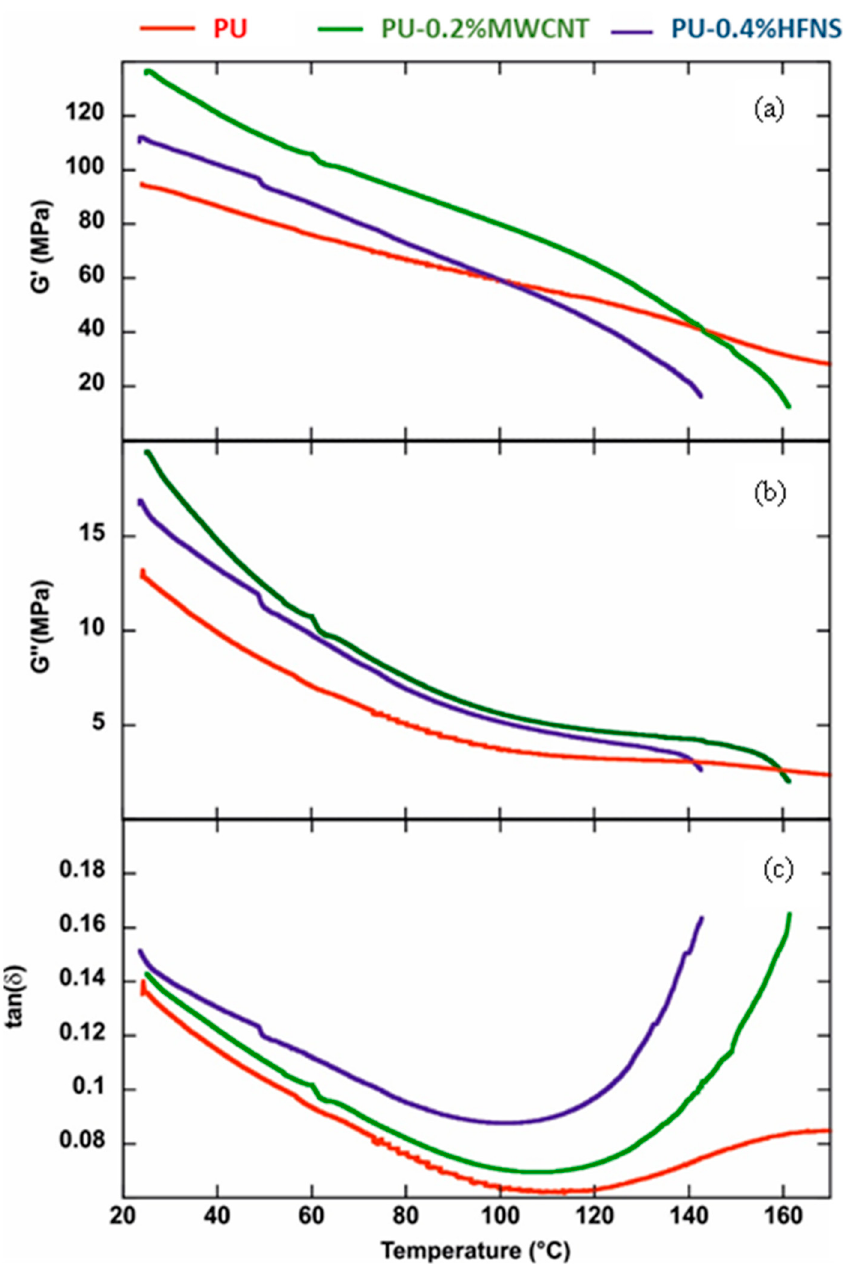
Figure 16. ( a ) Storage modulus, ( b ) loss modulus, and ( c ) tan ( δ ) as functions of temperature for PU, PU-0.2%MWCNT, and PU-0.4%HFNS films.